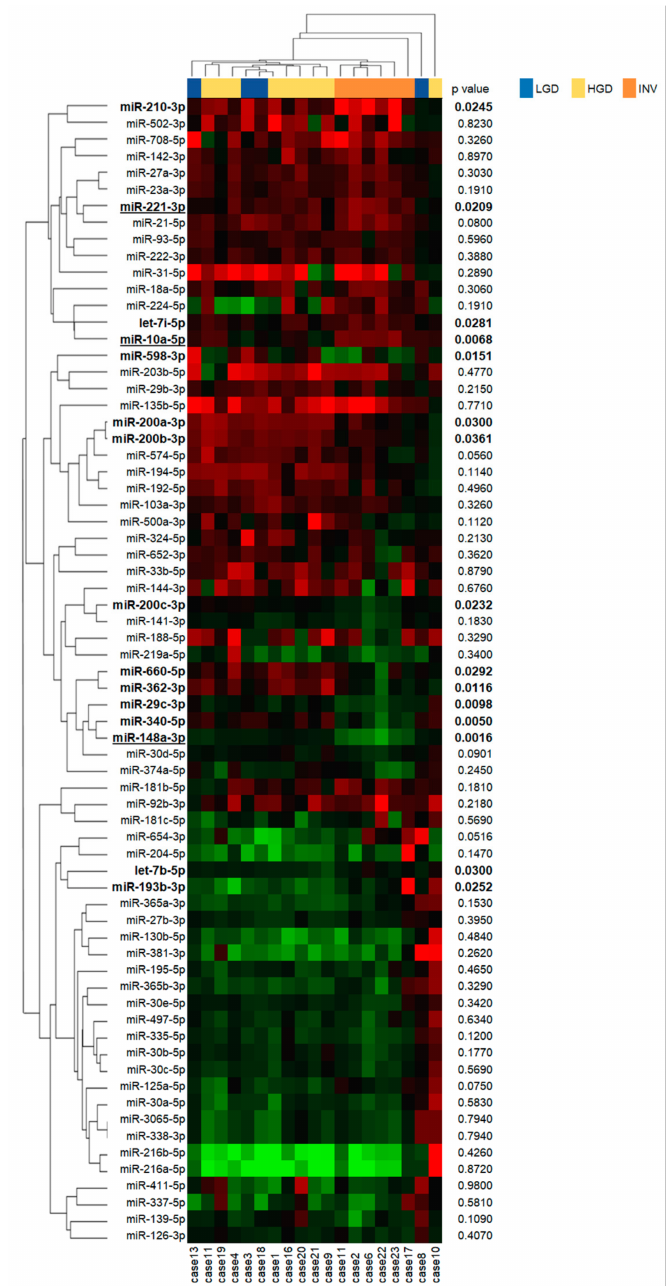
Figure 2. Heatmap of miRNA expressions stratified by pathological grades of intraductal papillary mucinous neoplasm (IPMN). The expressions of each miRNA in the IPMN tissues are shown as a heatmap. The expression levels of miRNAs are shown on a green-red scale in the center panel where the green and red should be interpreted as a low and high expression, respectively. The right panel shows the p -values by a Kruskal–Wallis test comparing three pathological grades (bold p value < 0.05). The left and upper panels show miRNAs and patients that were arranged according to an unsupervised hierarchical clustering, which was performed using a one minus Pearson’s correlation as the distance measure and an average linkage as the agglomerative method. LGD, low-grade dysplasia; HGD, high-grade dysplasia; INV, invasive carcinoma. MiRNAs with underlines show significant differential expressions between INV and non-INV (LGD and HGD)